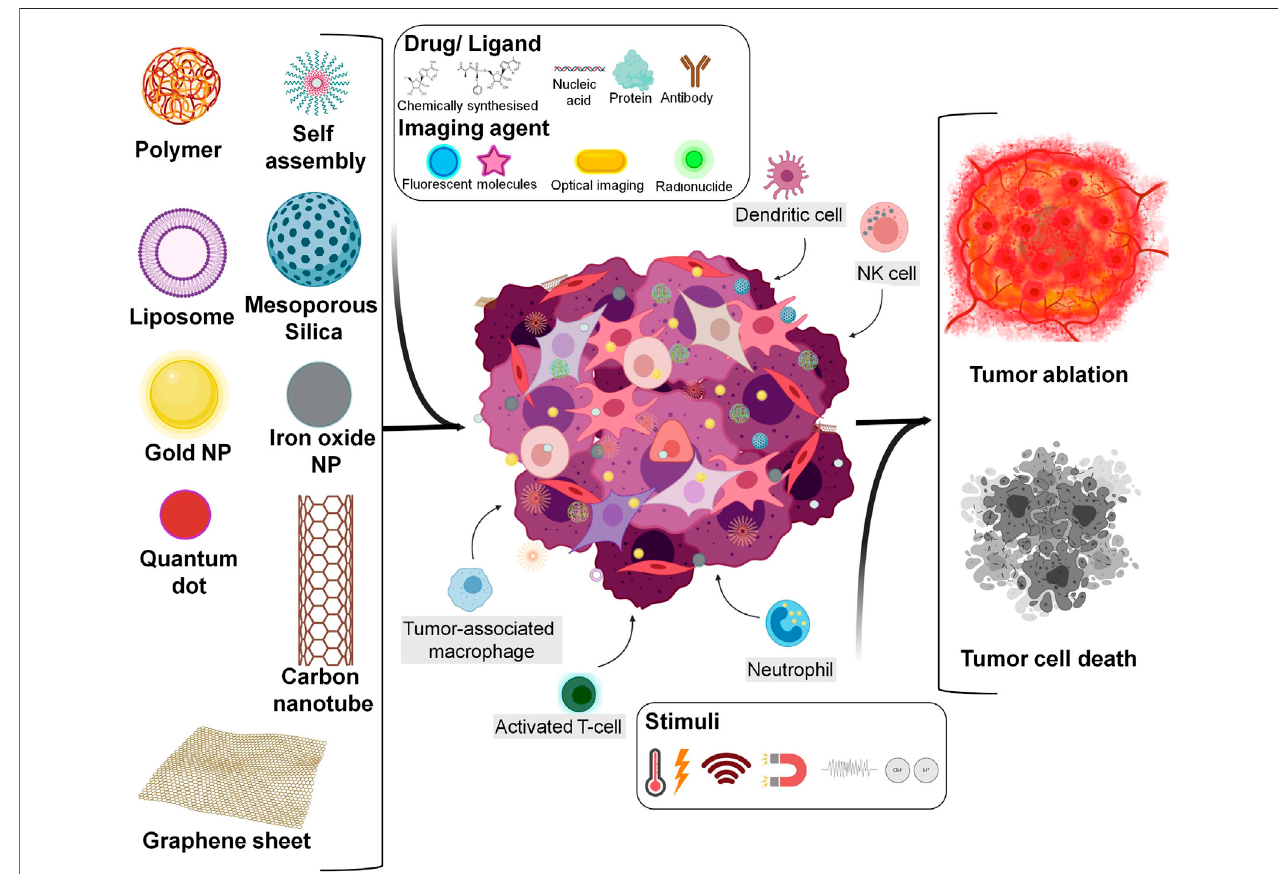
FIGURE 1 | Overview stating types of engineered nanomaterial synchronised with immune cell activation for tumor destruction (Created with BioRender.com).